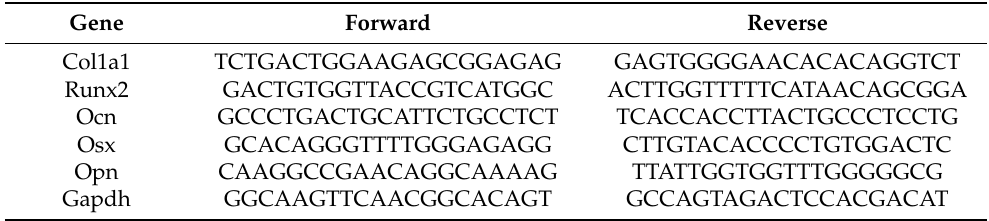
Table 2. Primer design table for